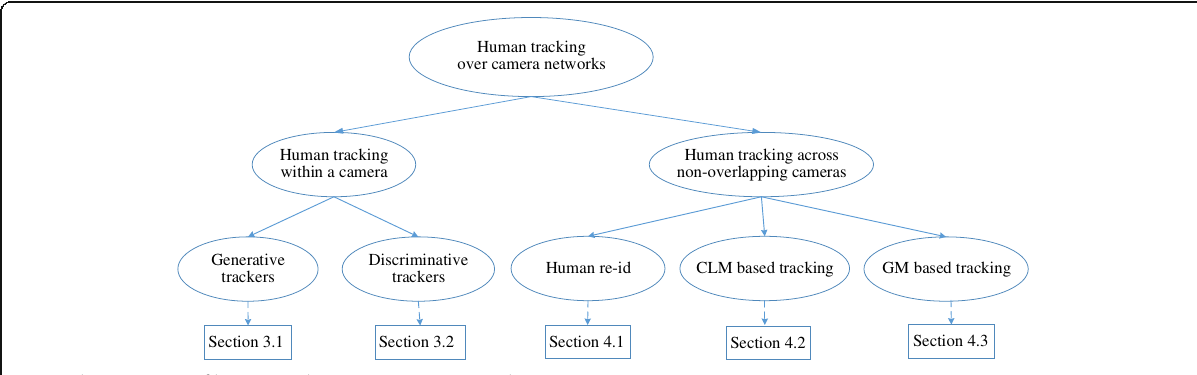
Fig. 2 The taxonomy of human tracking over camera networks